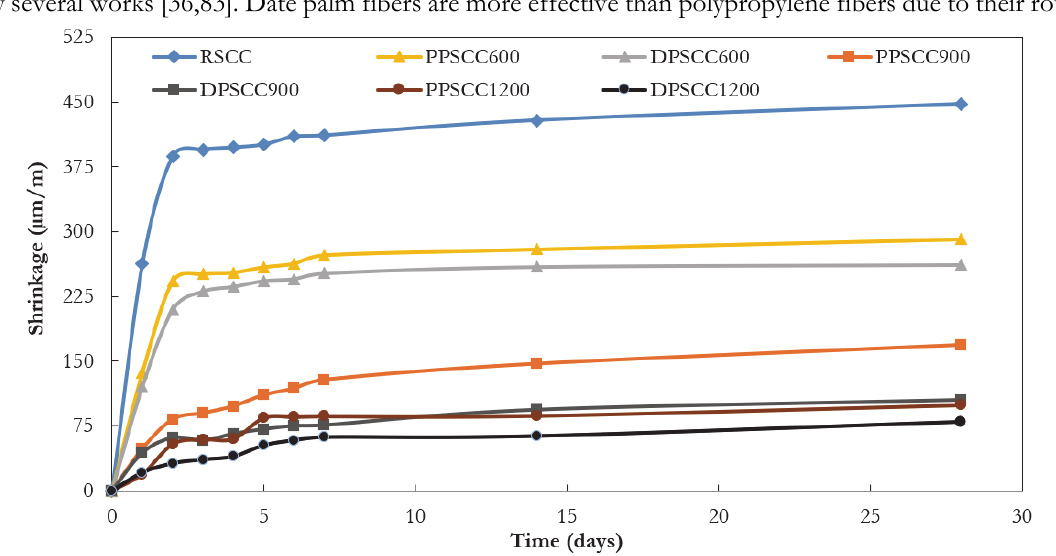
Figure 19: Effect of polypropylene and Date Palm fiber on shrinkage of SCC.